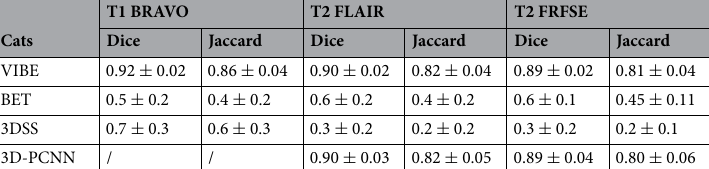
Table 4. Cats cohort results. Comparison of the mean and standard deviation results of both the Dice similarity coefficient and Jaccard index for three different MRI contrasts (T1 BRAVO, T2 FLAIR and T2 FRFSE) and different algorithms (VIBE, BET, 3DDS and